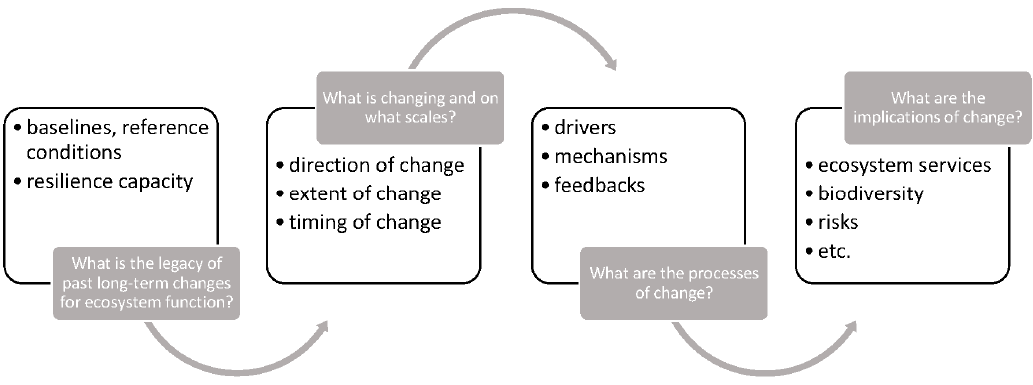
Figure 2. Synthesis of how the application of the paleolimnological approach can inform management and conservation of ecosystems.